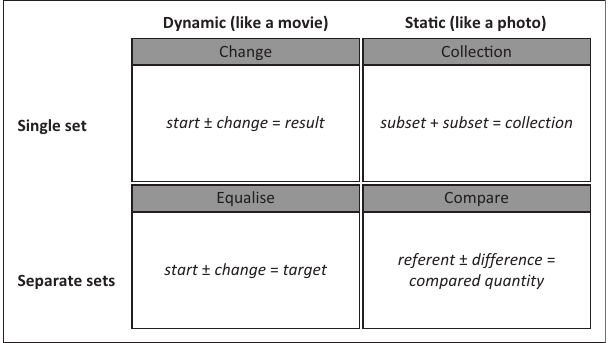
FIGURE 2: Four different types of word problems according to Carpenter et al. (1981).